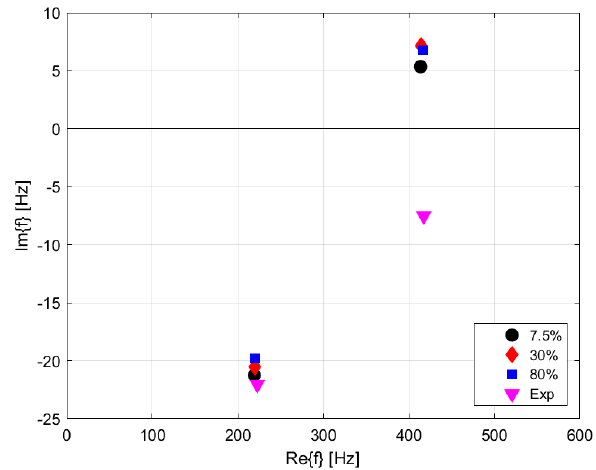
Table 4. Growth rate GR of instabilities.